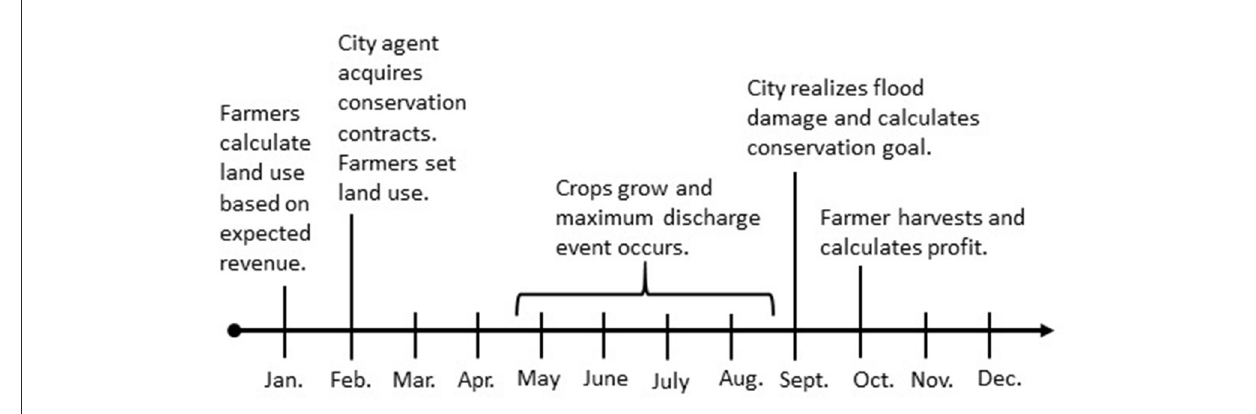
FIGURE2 Annual timeline of agent decisions and actions in the model.